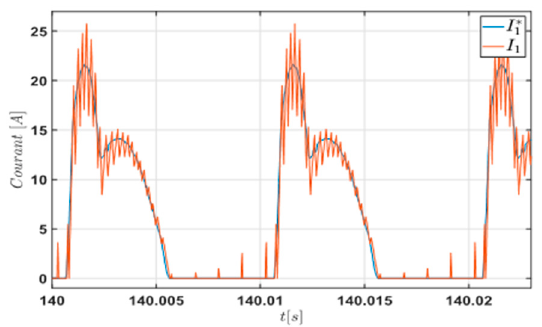
Figure 16. Current response of phase 1 using SMC.